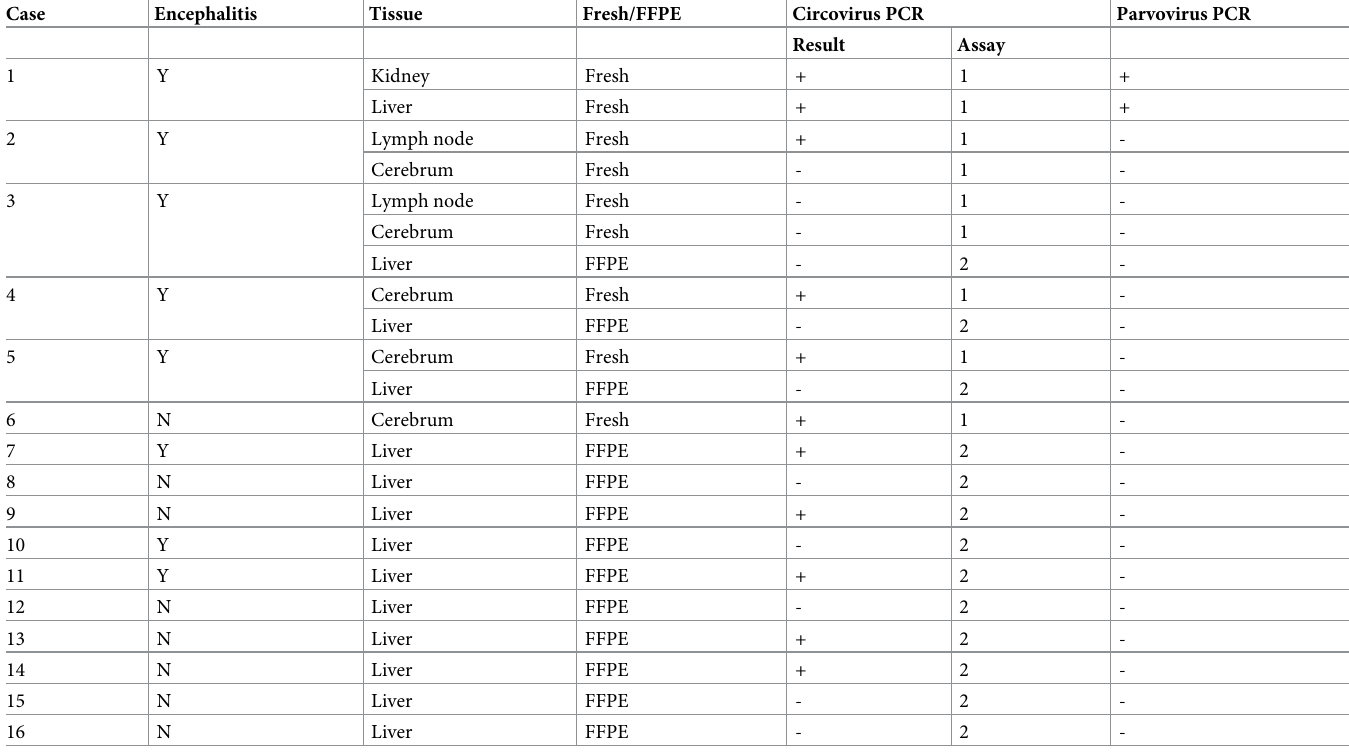
Table 3. PCR detection of circovirus and parvovirus in black bear tissue samples. Case Encephalitis